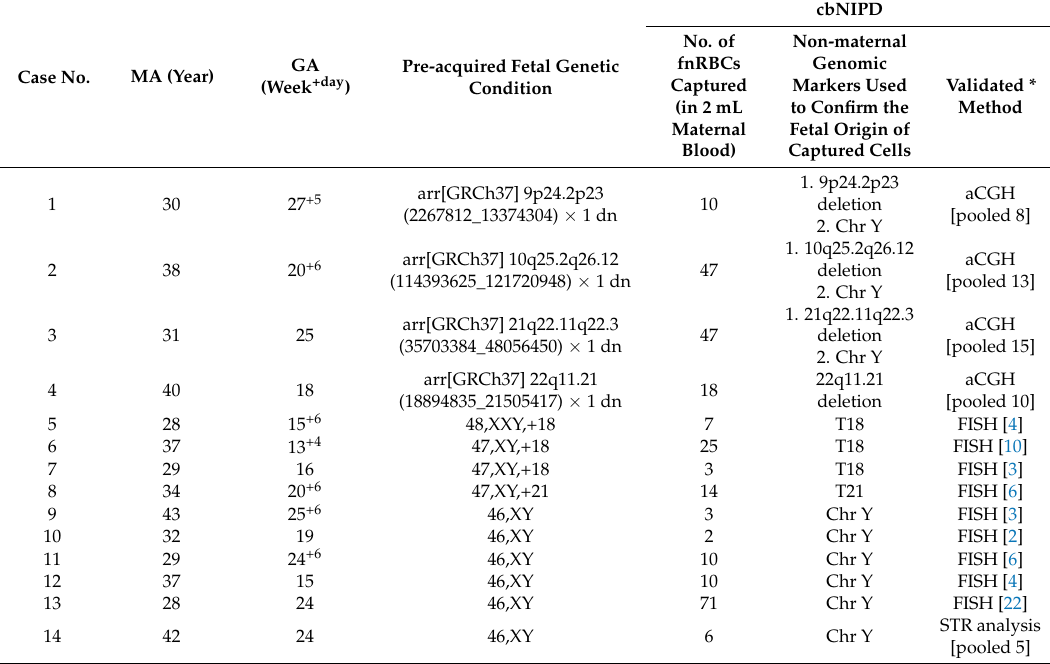
Table 2. The validation of the cell-based noninvasive prenatal diagnosis (cbNIPD) in 14 pregnant